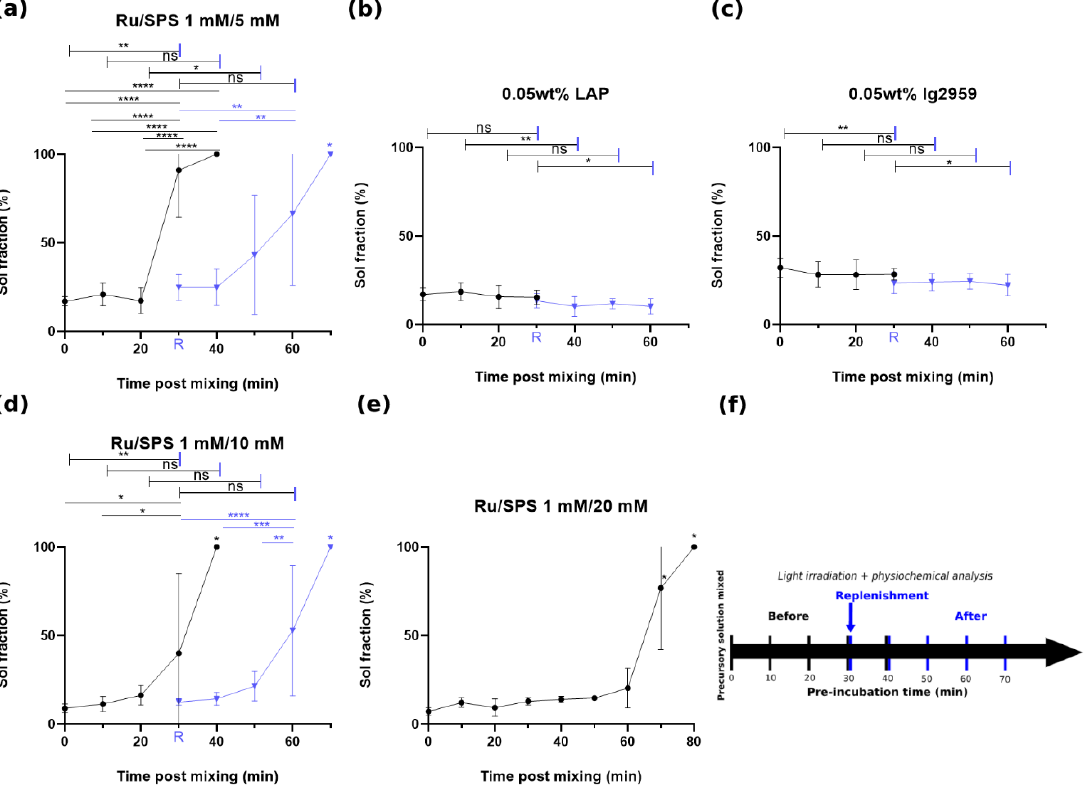
Figure 1. Sol fraction of GelAGE versus pre-incubation time prior to crosslinking with flow chart, circle ( • ) represents crosslinking with designated time of pre-incubation and triangle ( ▼ ) represents the samples with further pre-incubation after replenishment of photoinitiator at t = 30 min: ( a ) Sol fraction: 1 mM/5 mM Ru/SPS, ( b ) Sol fraction: LAP, ( c ) Sol fraction: Ig2959, ( d ) Sol fraction: 1 mM/10 mM Ru/SPS, ( e ) Sol fraction: 1 mM/20 mM Ru/SPS and ( f ) flow chart of the experiment. Values in the figures represent means and standard deviation of N = 9 replicates. Capped lines are for comparison with different groups (before and after replenishment). Asterisks (*) represents values statistically significant at the p < 0.05 level, ** for p < 0.01, *** for p < 0.001 and **** for p < 0.0001. ns represents values statistically